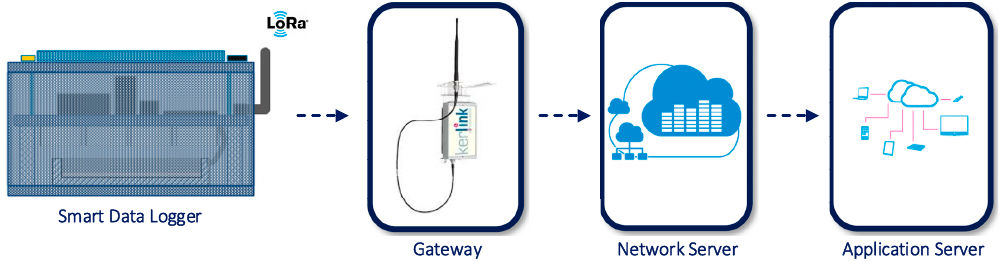
Figure 16 . Smart Data Logger Network link to the Back-End Server using LoRa infrastructure . Figure 16. Smart Data Logger Network link to the Back-End Server using LoRa